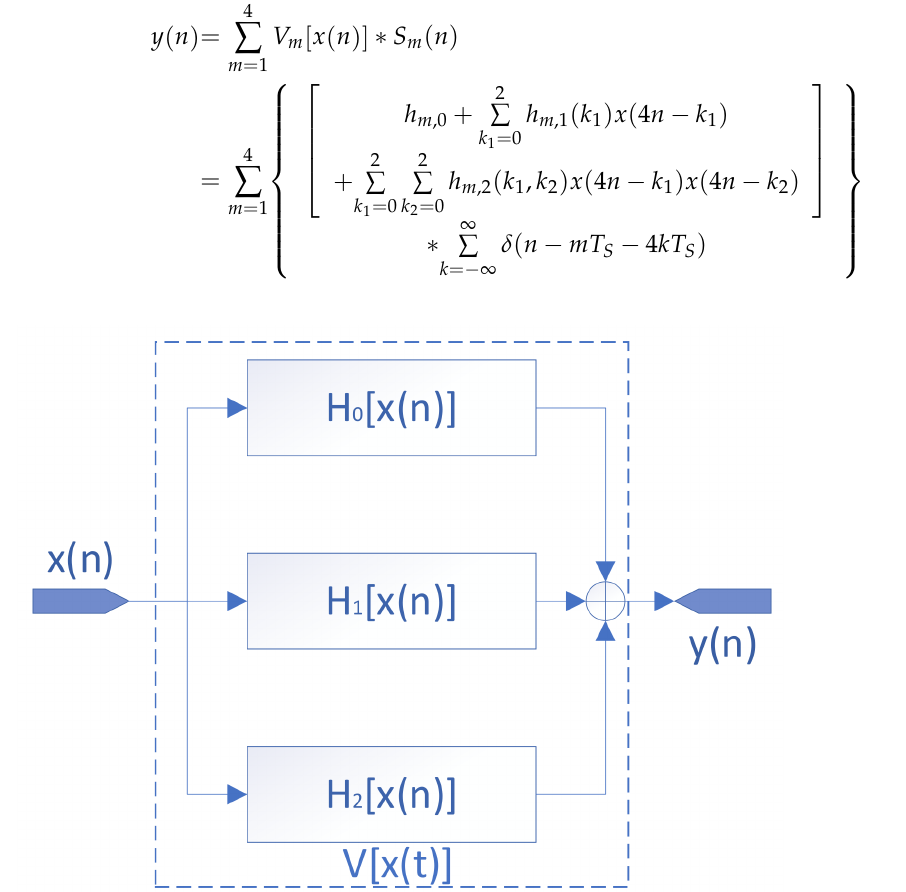
Figure 2. Three-order Volterra series model of a single ADC. The TIADC system block diagram is shown in Figure 3.